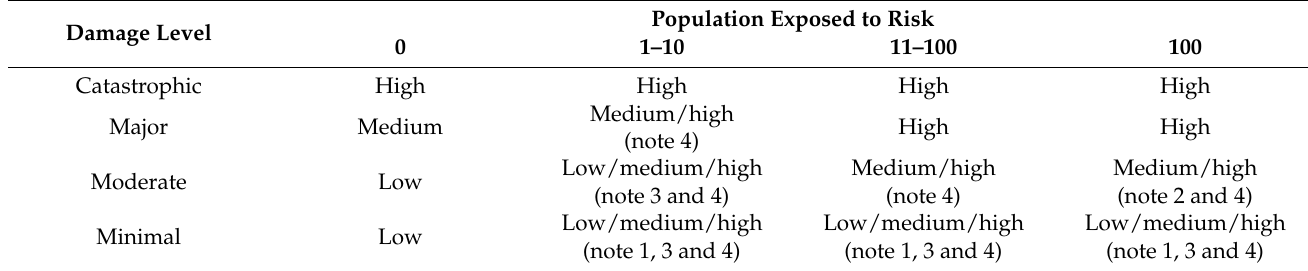
Table 4. Determination of potential impact by [30] is licensed under CC BY 4.0.